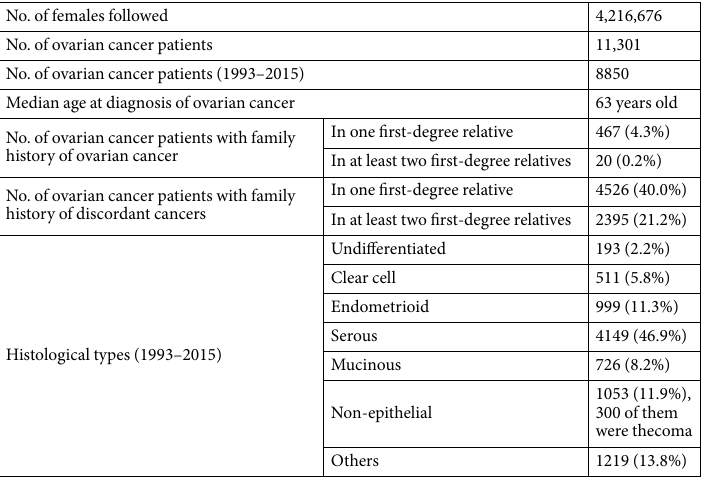
Table 1. Characteristics of ovarian cancer patients in offspring generation (1958–2015). Others include histological types of other ovarian cancers such as papillary ovarian cancer, as well as unspecified ovarian cancers.